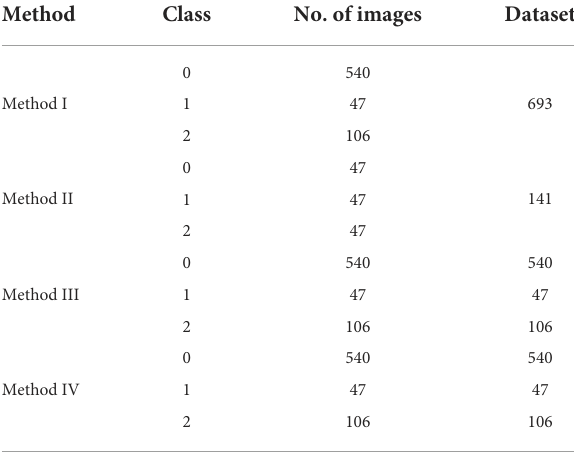
TABLE 1 Number of data in the individual